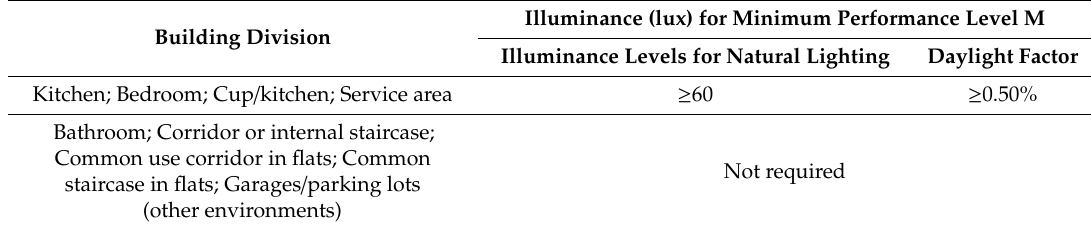
Table 8. Illuminance levels for natural lighting and daylight factor for di ff erent housing